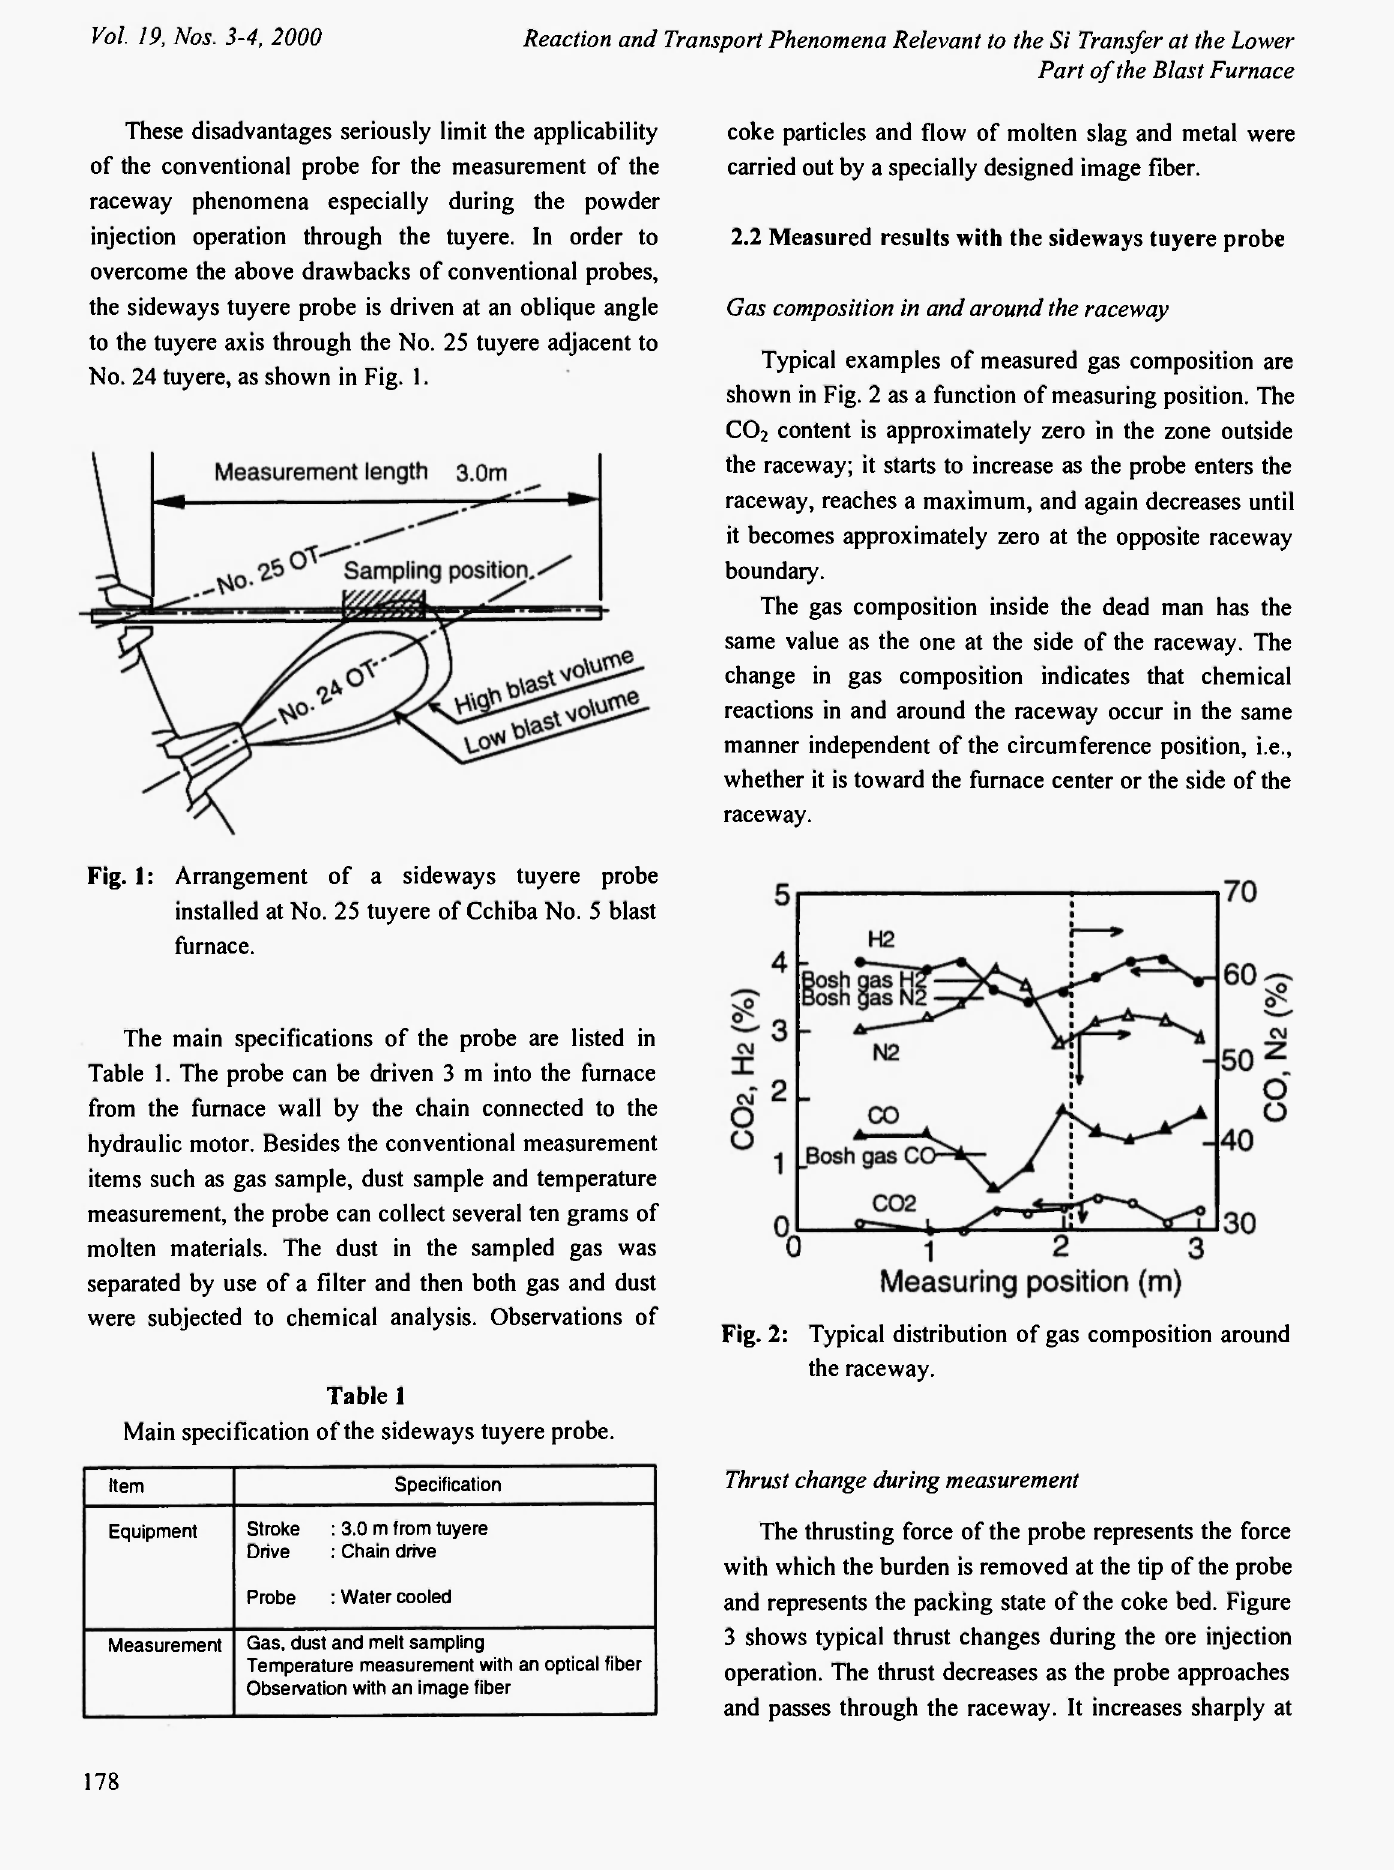
Main specification of the sideways tuyere